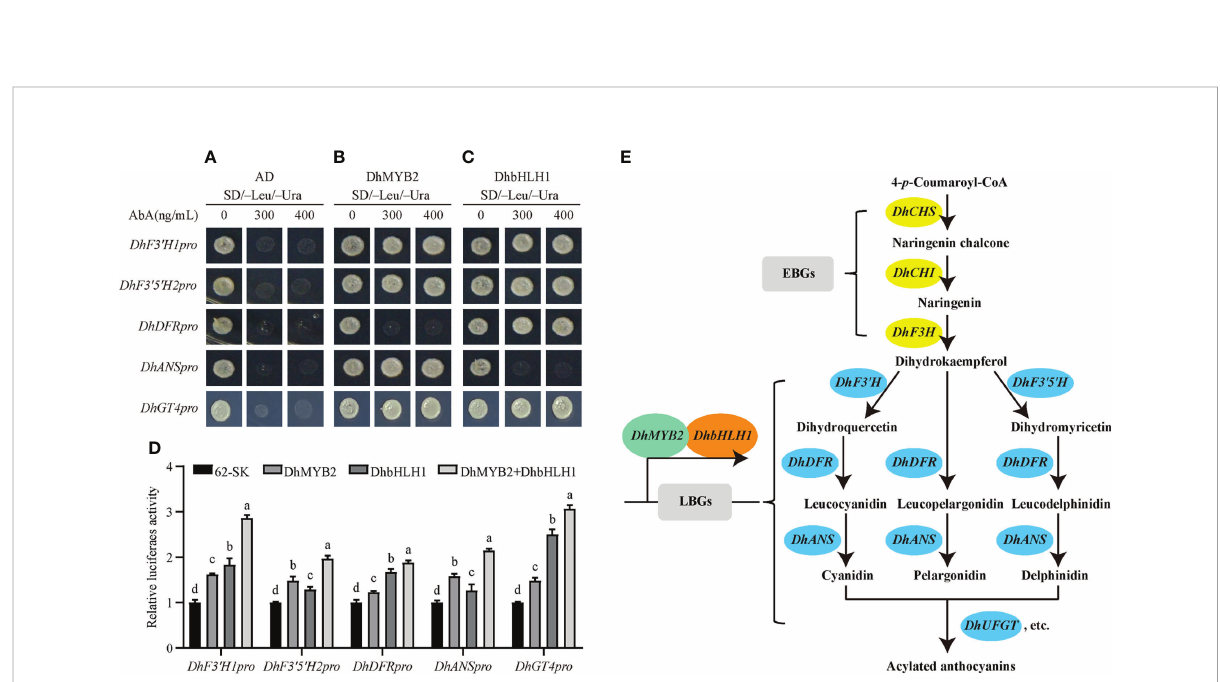
FIGURE 7 Yeast one-hybrid (Y1H) and dual ‐ luciferase reporter assays showing the association of DhMYB2 and DhbHLH1 with promoters of ABP structural genes. The Y1HGold yeast stains harboring the promoter reporter were transformed with empty plasmid as negative control (A) , effector DhMYB2 (B) , or effector DhbHLH1 (C) , respectively. Interaction was detected based on the ability of transformed stains to grow on SD medium lacking Leu and Ura in the presence of 300 or 400 ng/mL AbA. (D) Luciferase activity in tobacco leaves was detected 3 days after in fi ltration. Fire fl y luciferase (LUC) activities were normalized against Renilla luciferase (REN) activities. Graphs are presented as mean ± SEM from three biological replicates. Different letters indicate signi fi cant differences ( p < 0.05, Duncan ’ s multiple range tests). (E) Schematic representation of the suggested role of DhMYB2 and DhbHLH1 in ABP. Metabolic enzymes involved in the pathway are indicated. DhMYB2 and DhbHLH1 binding to promoter of LBGs act as activators in